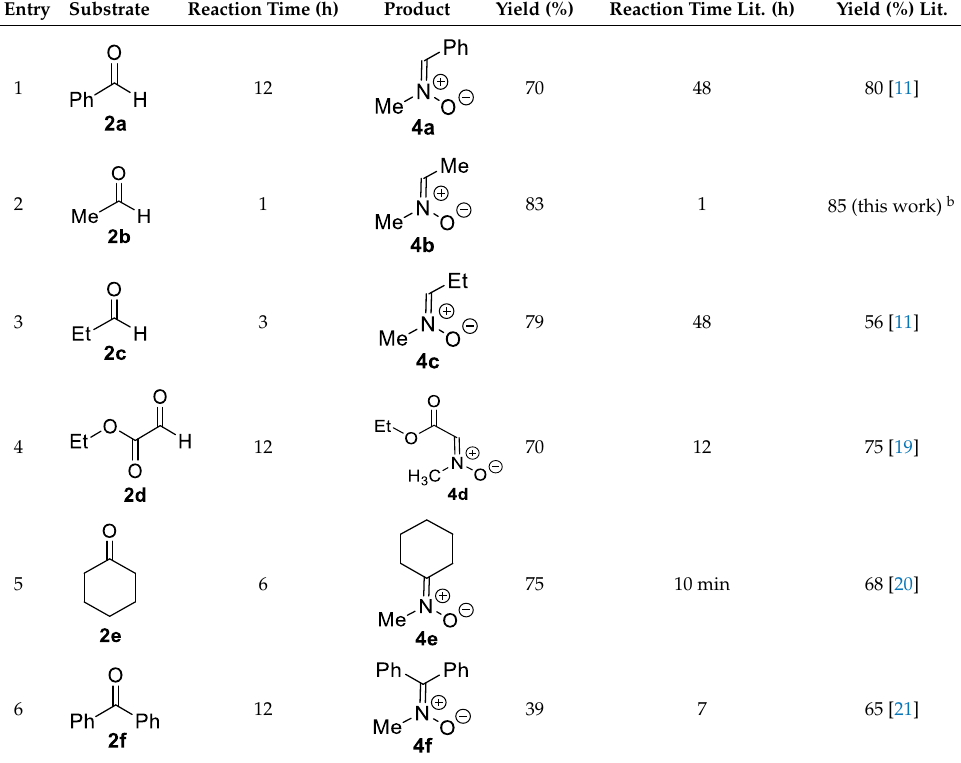
Table 2. Reaction times and yields obtained with the capsule and reported in the literature a .